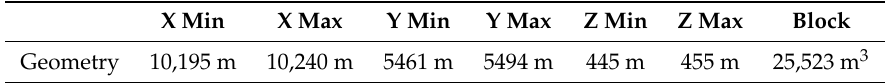
Table 1. Bench blasthole geometry.